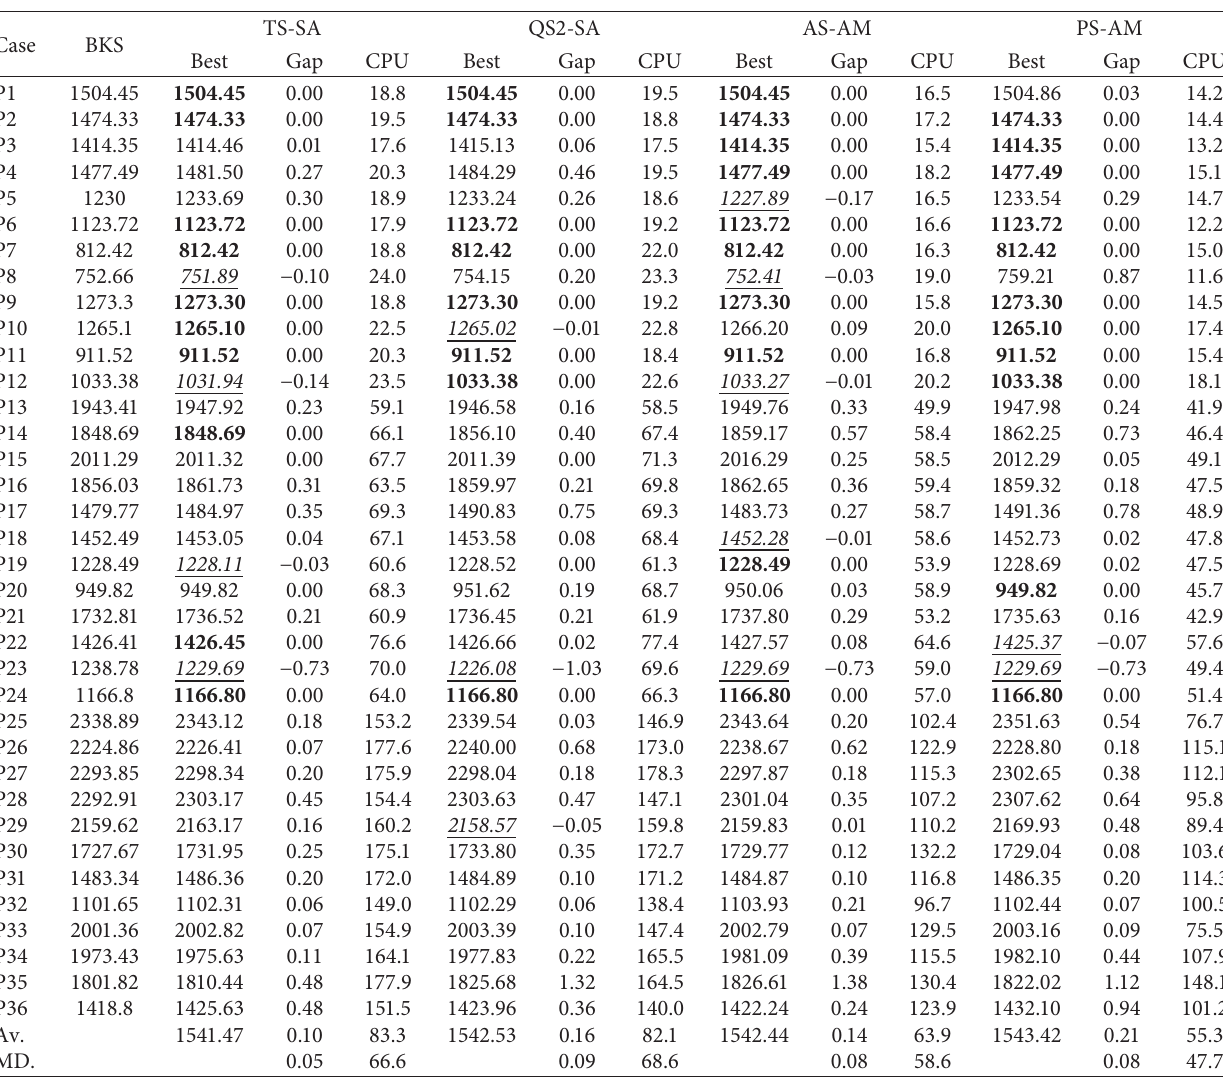
Table 10: Results for the CLRPSPD instances in Tuzun and